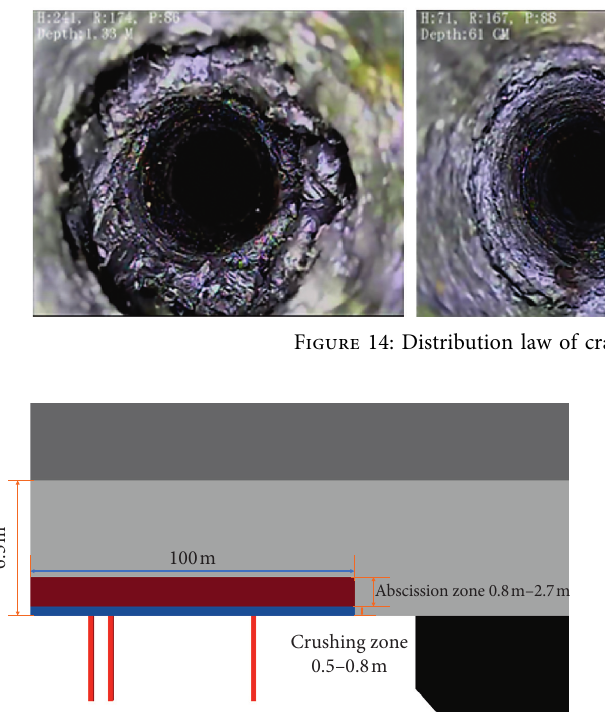
Figure 15: Distribution of roof separation